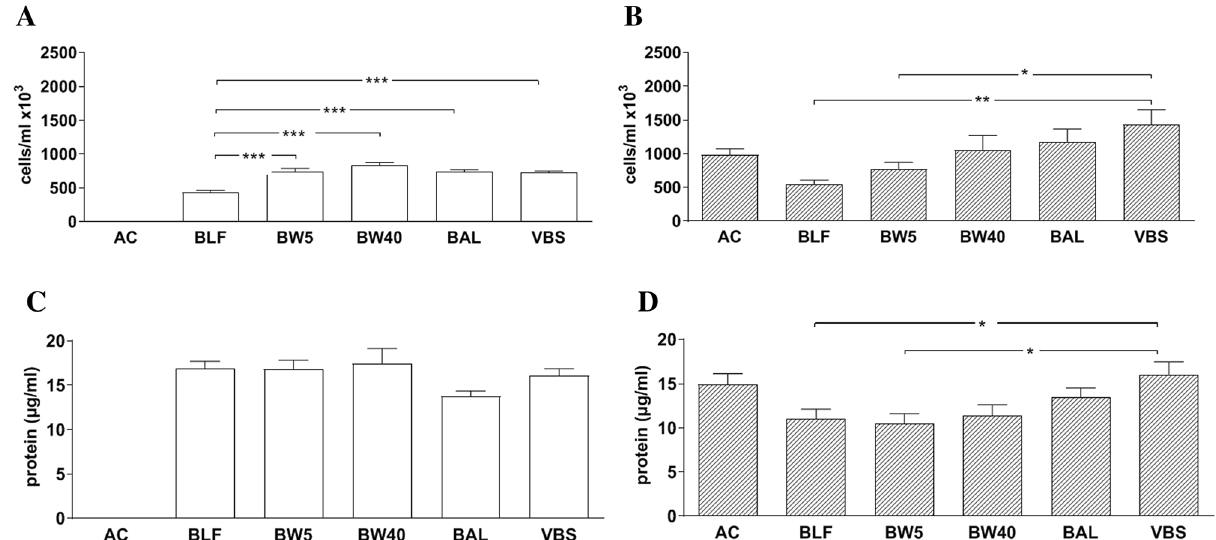
Figure 2. The effect of sampling technic on cell number (upper panel) and protein concentration (lower panel) in mucus dissolved samples obtained from five control subjects ( A , C ) or thirty-five mechanically ventilated patients ( B , D ). Sampling was performed via tracheobronchial aspiration (AC), aspiration of bronchial lining fluid (BLF), bronchoalveolar lavage (BAL), bronchial washings (BW40 and BW5) or visible bronchial secretions obtained via bronchoscopy (VBS). Data are presented as mean ± SEM of independent samples with * p < 0.05, ** p < 0.01 and *** p < 0.001 for comparisons between sampling methods (ANOVA Bonferonni’s post hoc test).